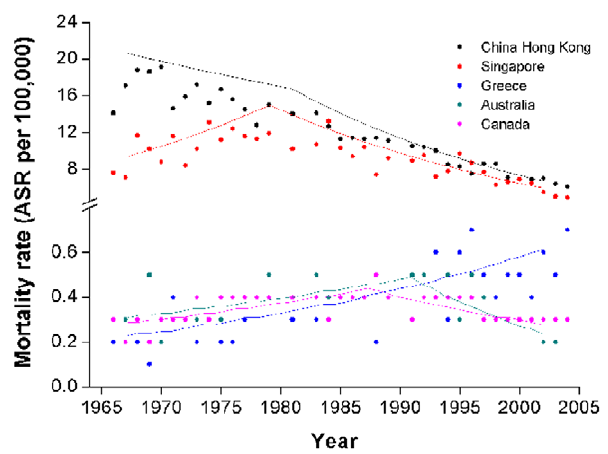
Figure 6. Representative joint point analysis output from NPC mortality data of China Hong Kong, Singapore, Greece, Australia and Canada. Dots represent observed value and lines represent modeled data. In this analysis, two join points were set.